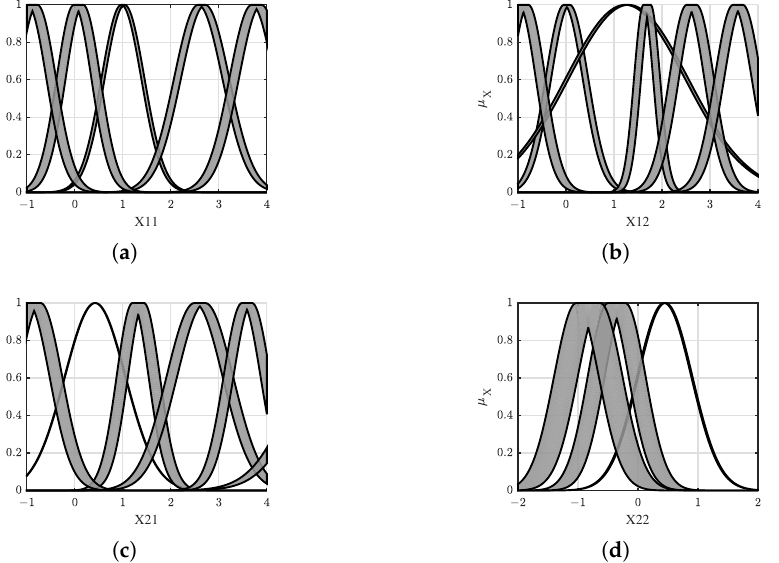
Figure 4. Fuzzy set of the entire DHSOIT2FS in 4.1. ( a ) Fuzzy set of SOFS1’s first dimension. ( b ) Fuzzy set of SOFS1’s second dimension. ( c ) Fuzzy set of SOFS2’s first dimension. ( d ) Fuzzy set of SOFS2’s second